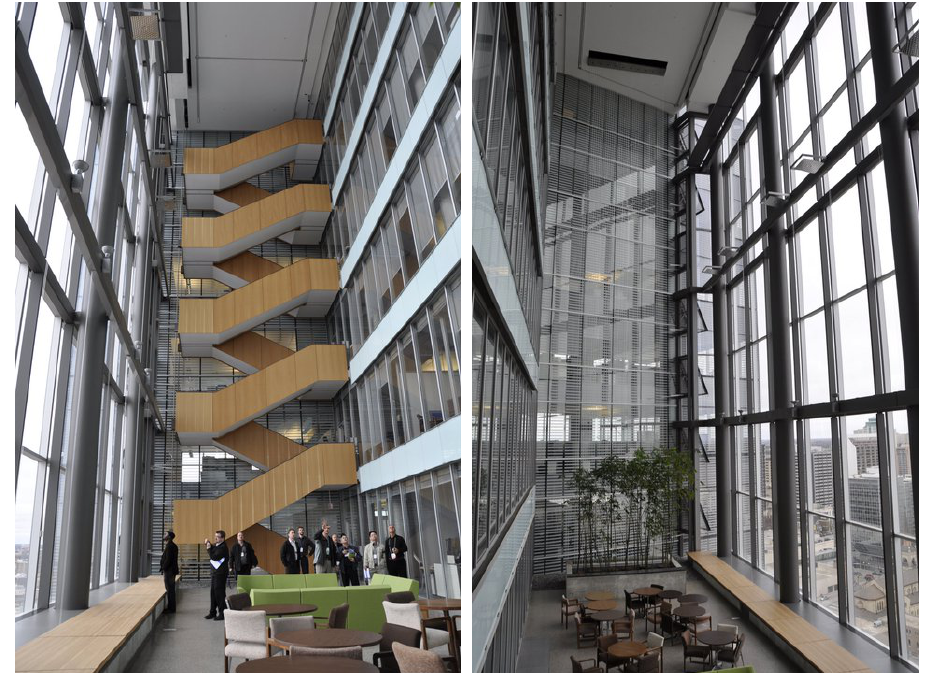
Figure 12. Manitoba Hydro Place, South facing Atrium (Courtesy Terri Boake, University of